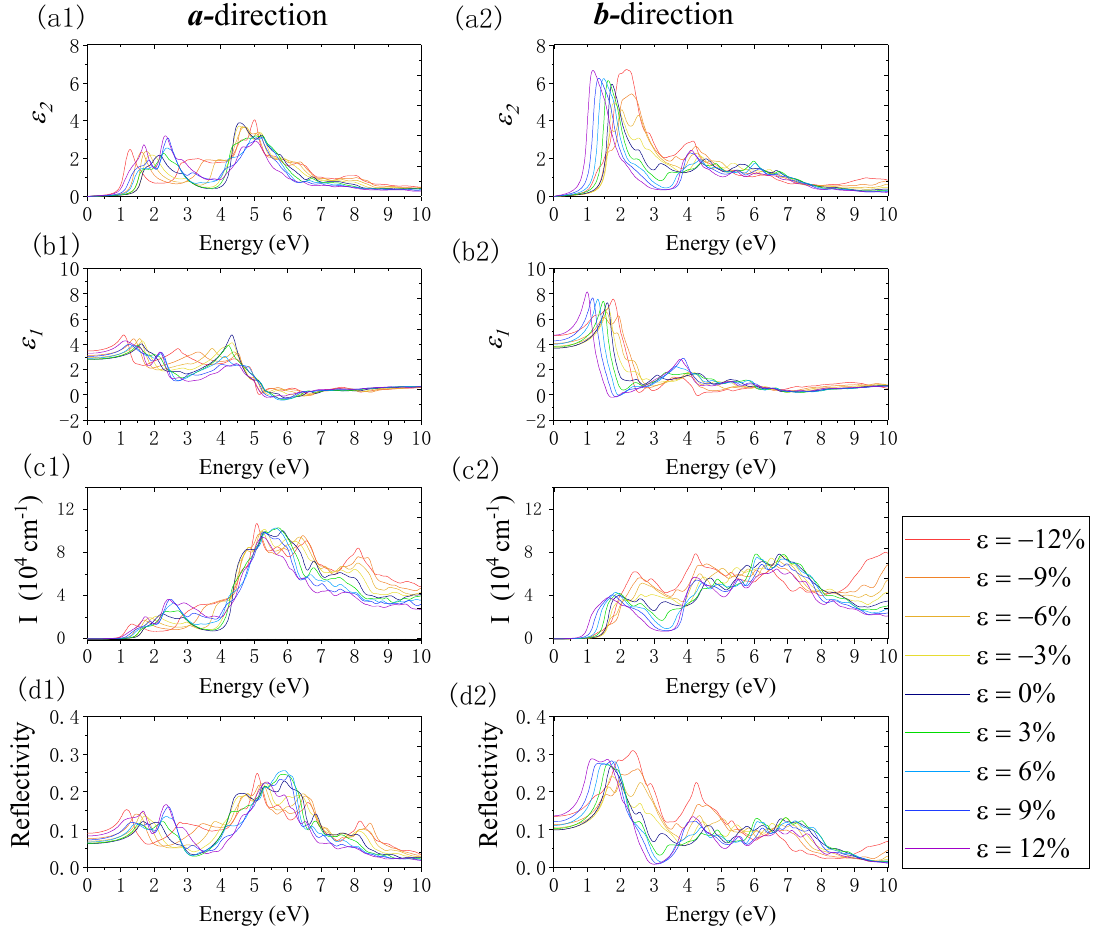
Figure 13. The changes in the imaginary part of the dielectric function ( ε 2 ), real part of the dielectric function ( ε 1 ), absorption coefficient (I), and reflection coefficient (R) when applying biaxial strain using the PBE method. Panels ( a1 – d1 ) and ( a2 – d2 ) show the results along the a - and b -directions, respectively. Overall, the optical properties of monolayer β -AuSe exhibited anisotropy in